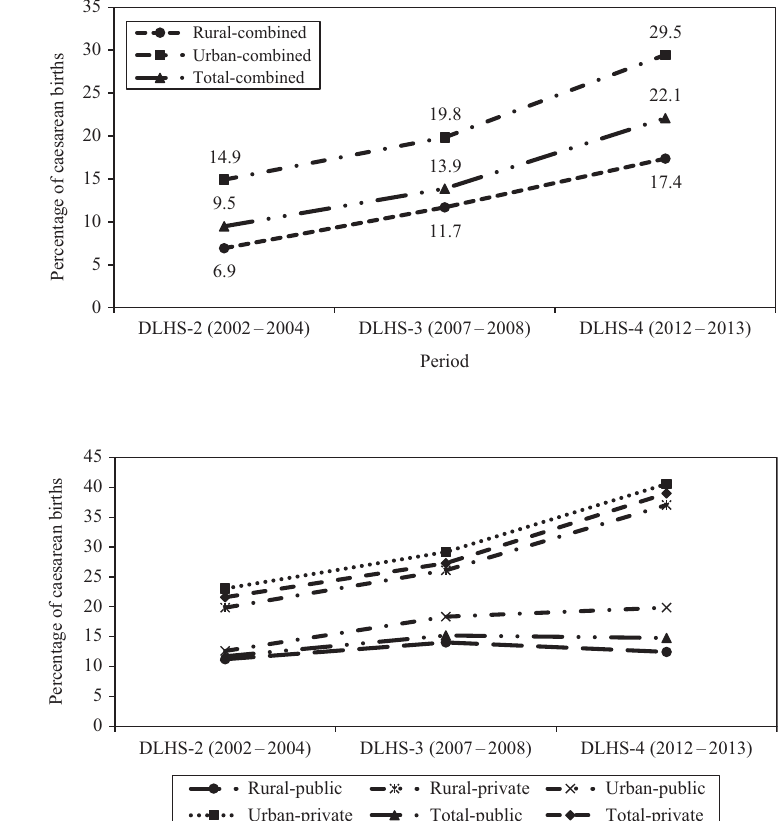
Figure 2. Prevalence (in percentage) of caesarean